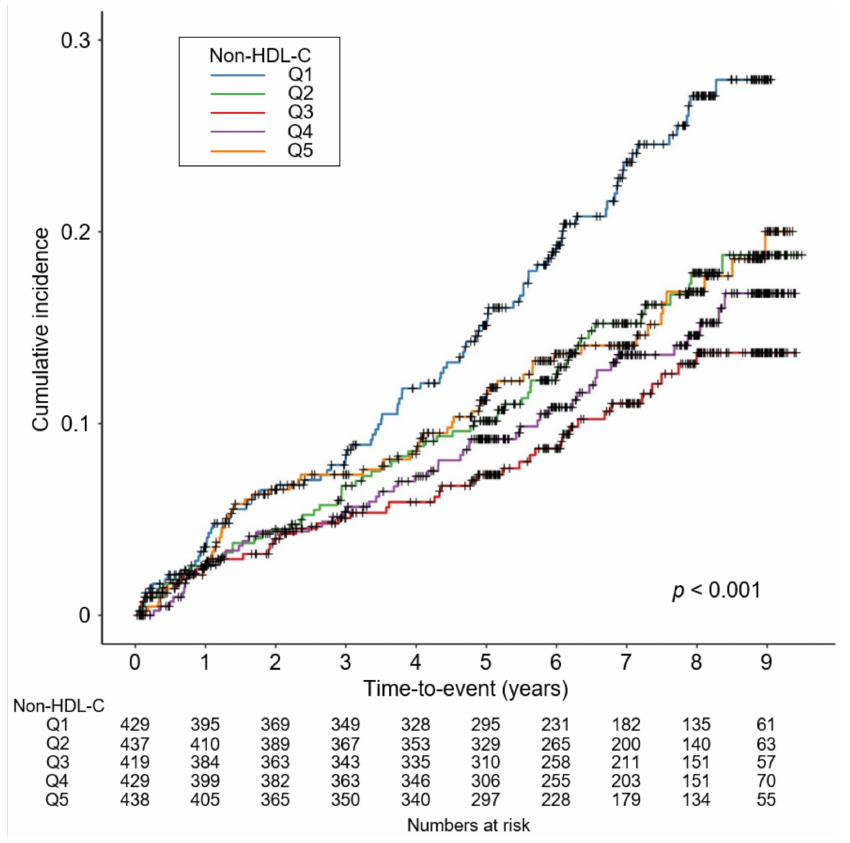
Figure 2. Kaplan–Meier survival curve for cumulative incidence of composite CV event by non-HDL-C. p value by Log-rank test. Abbreviations: CV, cardiovascular; HDL-C, high density lipoprotein cholesterol; Q1, 1st quartile; Q2, 2nd quartile; Q3, 3rd quartile; Q4, 4th quartile; Q5, 5th